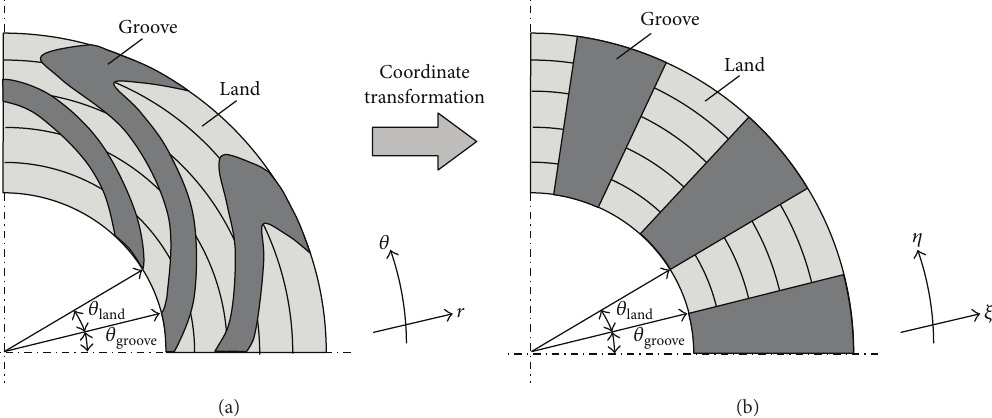
Figure 9: Bearing geometry transformation based on the boundary-fitted coordinate system; (a) Original bearing geometry, (b) Transformed bearing